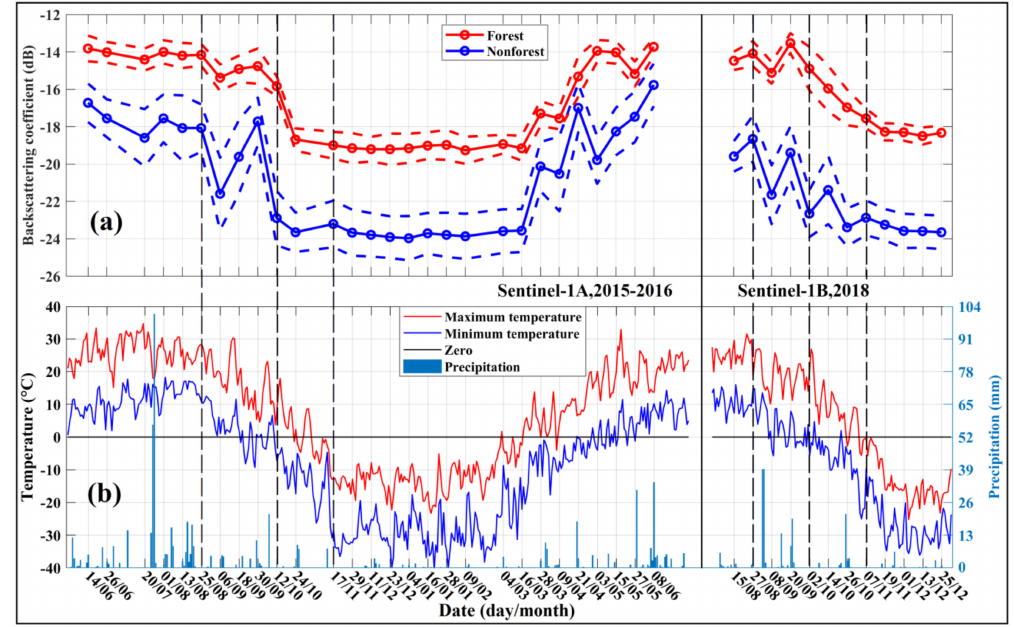
Figure 6. Time series of VH backscattering coe ffi cients on the type I and type VII sampling plots of the first group and corresponding daily temperatures and amount of precipitations within the scene of Strip-3-1: ( a ) Backscattering coe ffi cients of forest plots (in red) and non-forest plots (in blue), solid lines are the mean values and dotted lines are standard deviations; ( b ) Daily temperatures and amount of